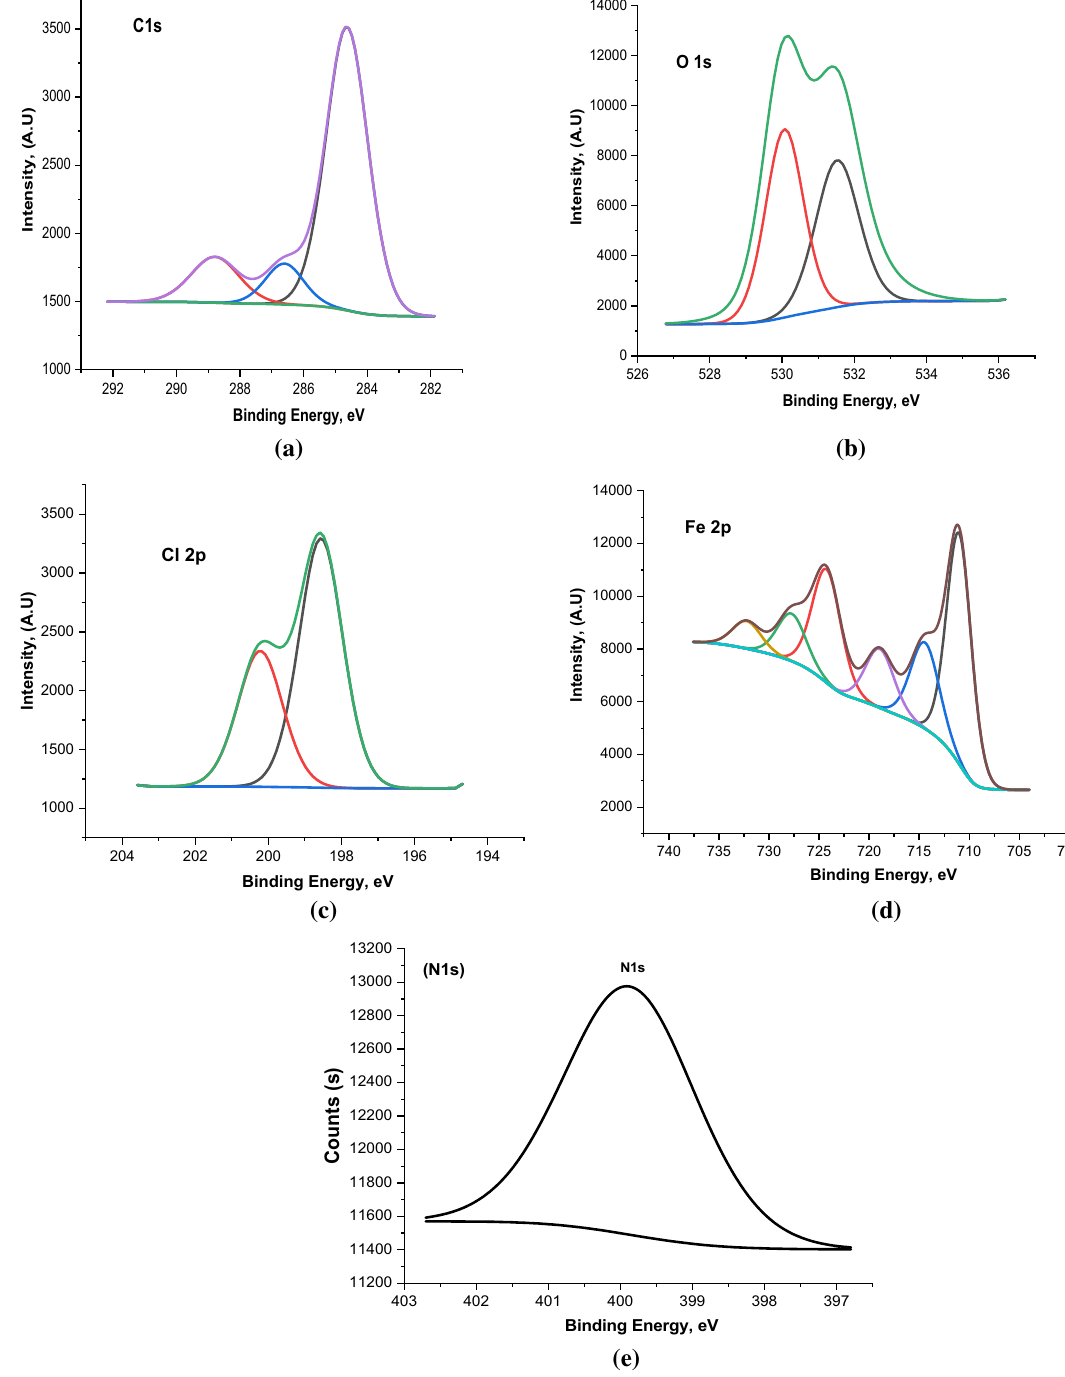
Figure 17. High-resolution X-ray photoelectron deconvoluted profiles of ( a ) C 1 s, ( b ) O 1 s, ( c ) Cl 2p, ( d ) Fe 2p, and ( e ) N 1s for carbon steel in 1 M HCl + carbonitrile